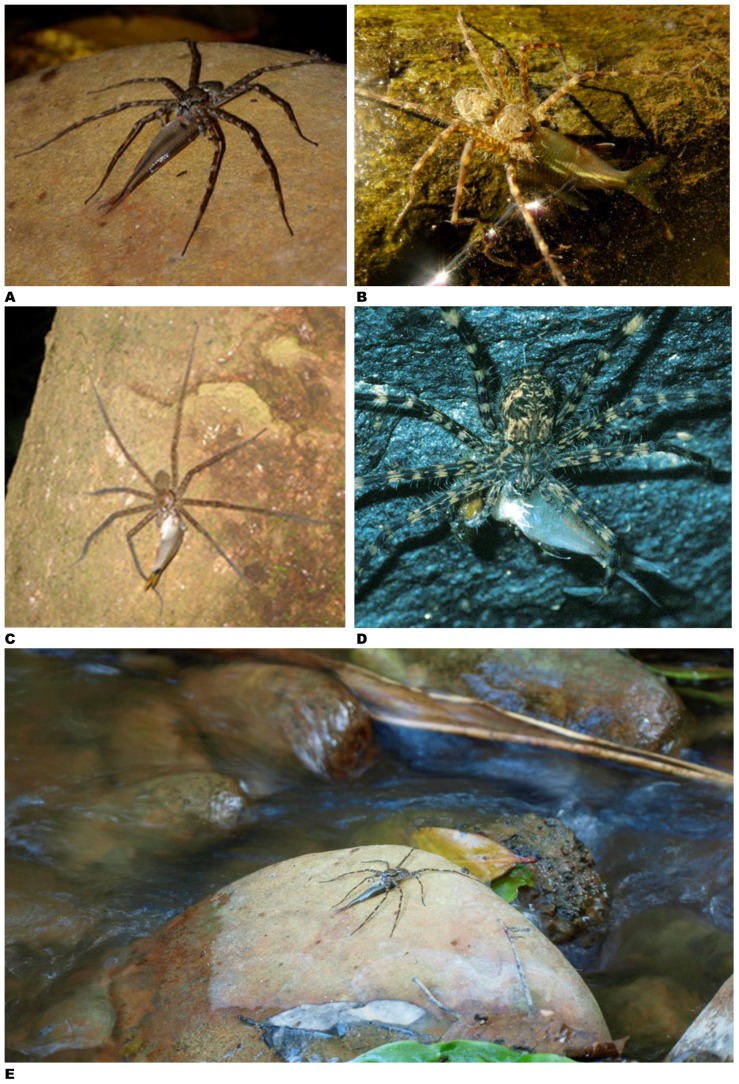
Fish caught by spiders – examples from the Neotropics.
A –
Trechalea sp. eating characiform while sitting on a rock in middle of small river near Paratebueno, Cundinamarca, Colombia (photo by Solimary Garcia Hernandez, Instituto de Biociências, Universidade de São Paulo, Brazil; report # 51). B –
Trechalea sp. pulling characiform on stone on edge of shallow, small stream near Quebrada Valencia, Magdalena, Colombia (photo by Juan Esteban Arias A., Cali, Colombia; report # 50). C –
Trechalea sp. devouring characiform while sitting on tree trunk on edge of Rio Frijoles, Central Panama (photo by Jessica Stapley, University of Sheffield, UK; report # 48). D –
Trechalea sp. eating characiform on bank of Rio Maicuru, Pará State, Brazil (photo by Jacques Jangoux, Belém, Brazil; report # 59). E –
Trechalea sp. eating characiform while sitting on rock in middle of small river near Paratebueno, Cundinamarca, Colombia (photo by Solimary Garcia Hernandez, Instituto de Biociências, Universidade de São Paulo, Brazil; report # 51).